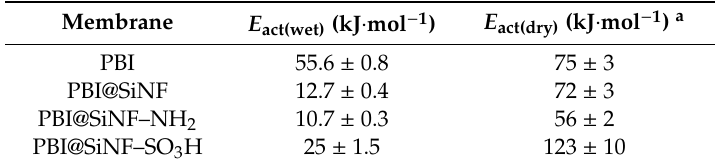
Table 3. Activation energies for the PBI composite membranes in wet and dry